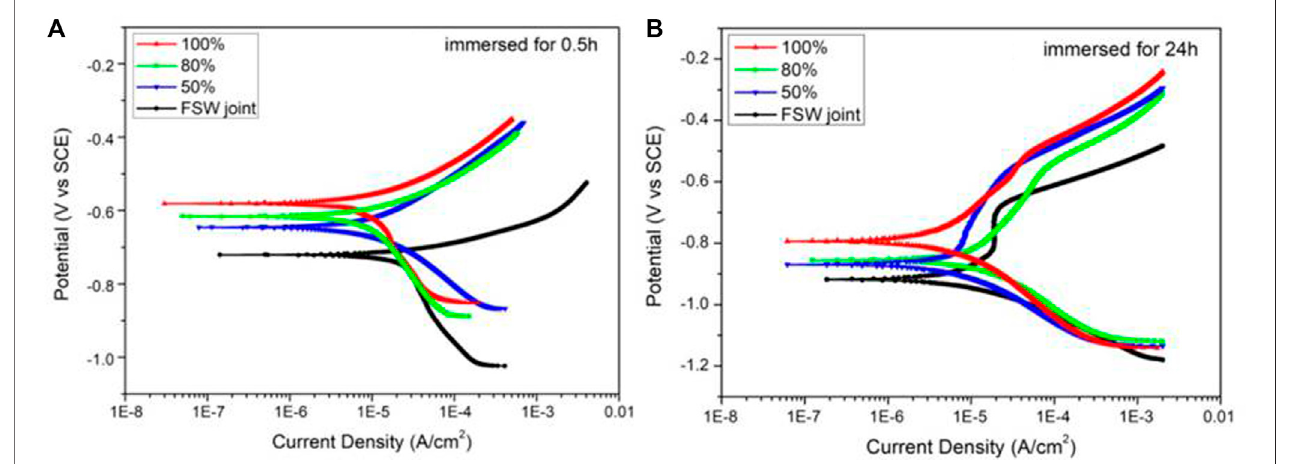
FIGURE 10 | PDP for FSW joint and Ni coatings immersed for 0.5 h (A) and immersed for 24 h (B) in simulated seawater.